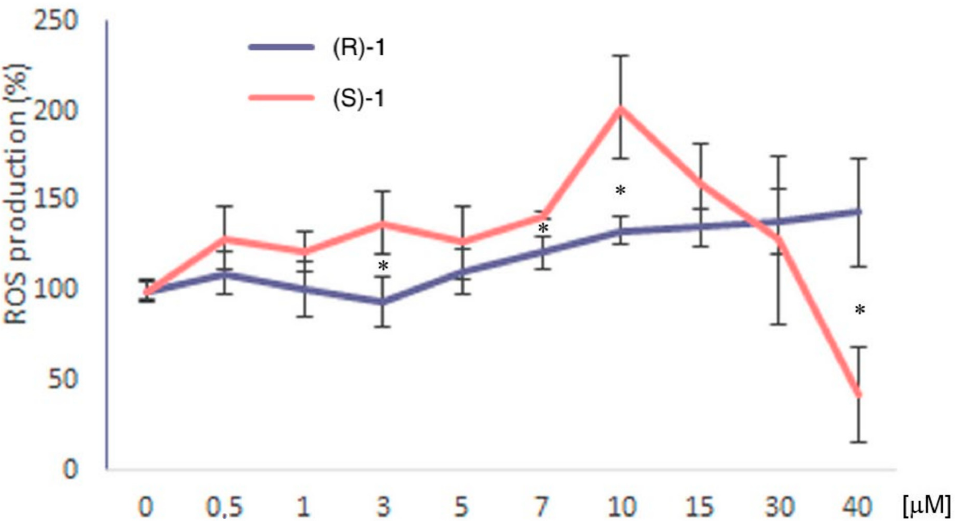
Figure 6. ROS production in HCT116 cells upon treatment with different concentrations of ( R )- 2 or ( S )- 2 for 48 h. The asterisks show the differences between the effects induced by the two drugs.